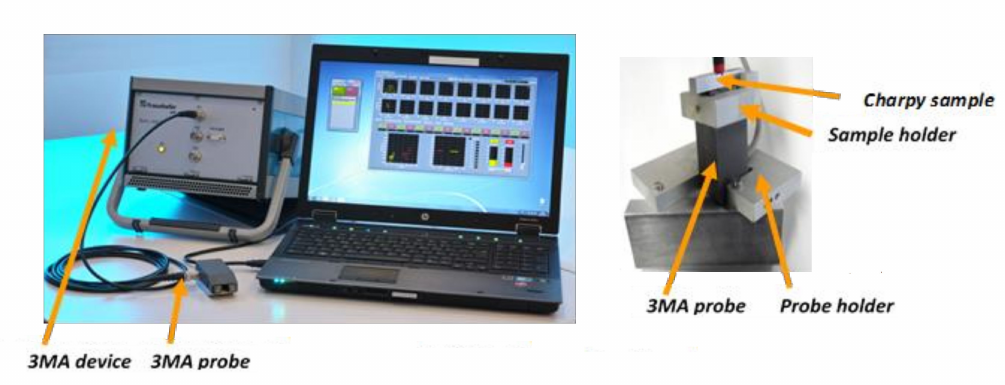
Figure 5. The micromagnetic multiparameter microstructure and stress analysis (3MA)-X8 system, including 3MA-X8 device, probe, and PC ( left ); ( right ) specimen holder and probe